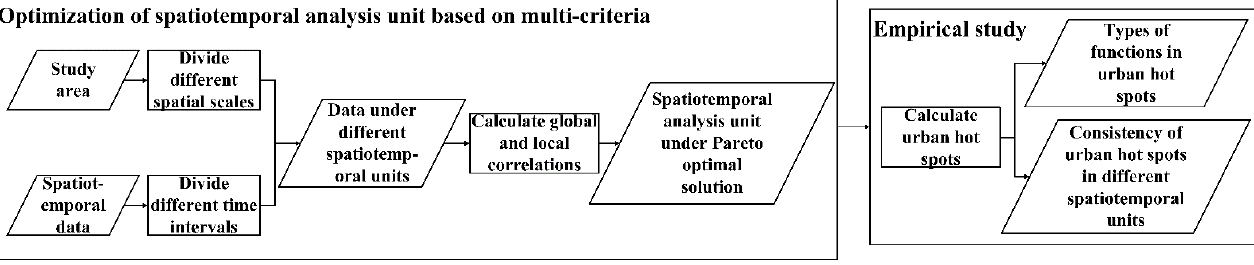
Figure 1. Overall